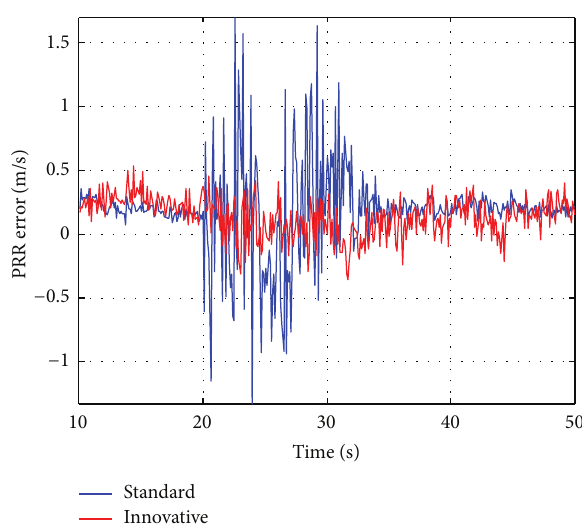
Figure 11: Performance of adaptive and standard IKFs.